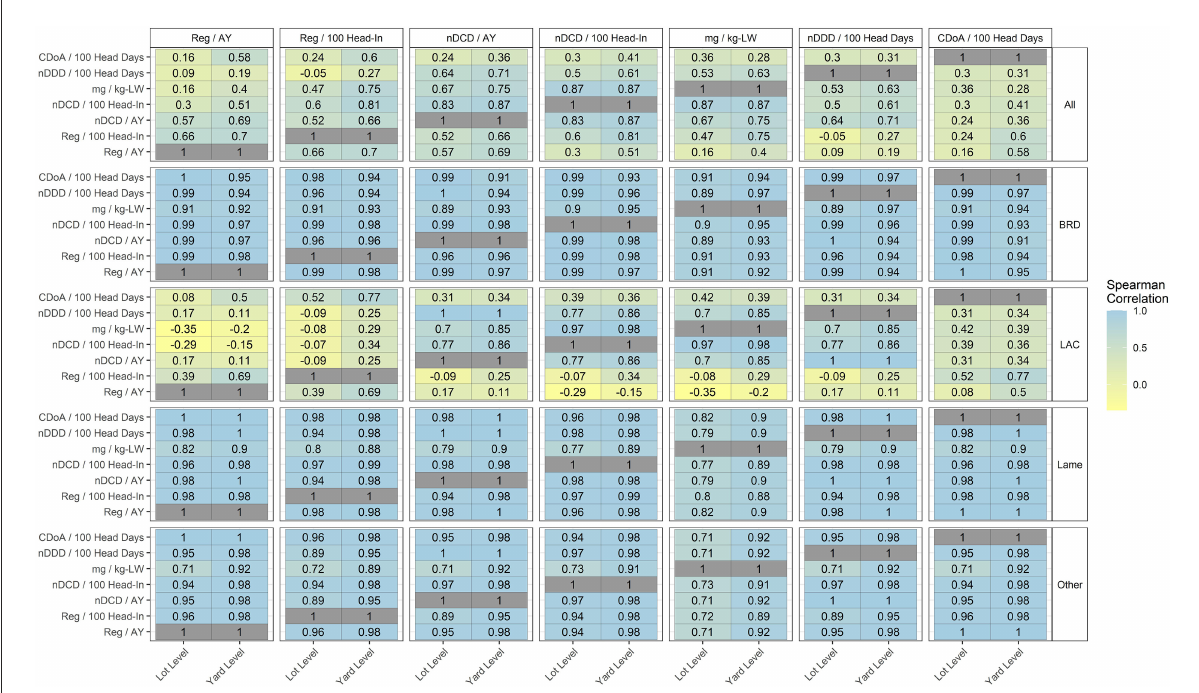
FIGURE7 Correlations of 7 metrics for medically important antimicrobial use monitoring by use indication at the lot and feedyard (yard) levels.